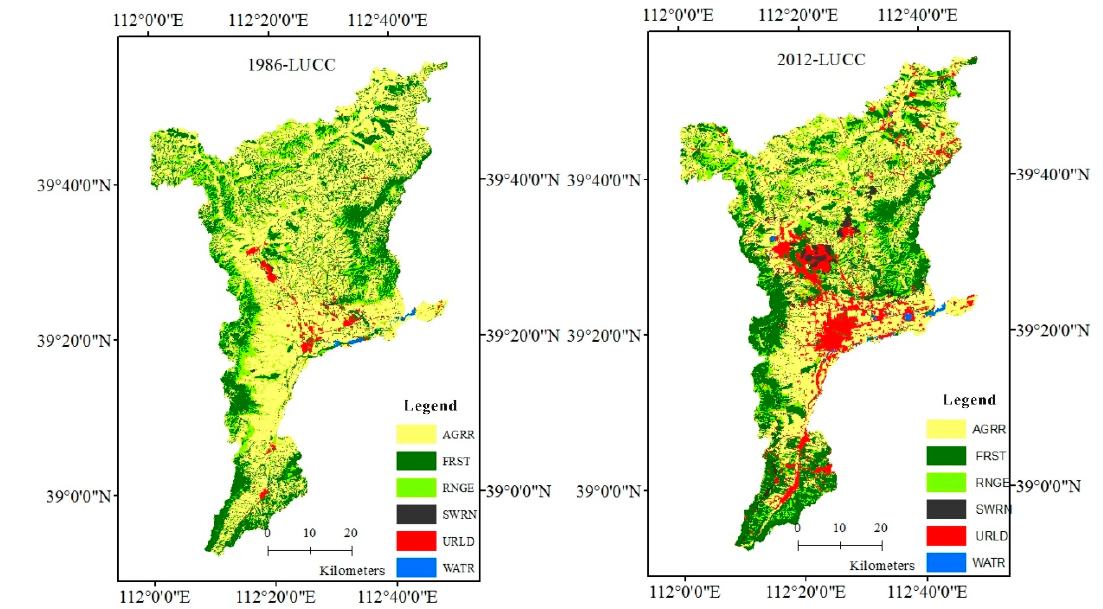
Figure 3. Land use maps of the USK river basin in 1986 and 2012.